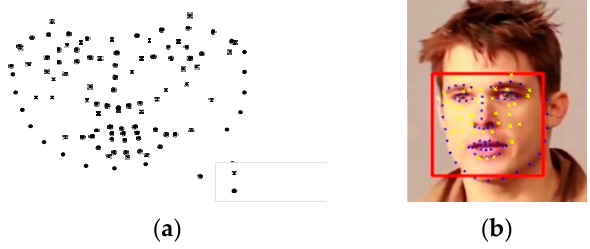
Figure 5. Acupoint visualization. ( a ) acupuncture model; ( b ) warped acupoints. Figure 5. Acupoint visualization. (a) acupuncture model; (b) warped acupoints. Figure 5. Acupoint visualization. (a) acupuncture model; (b) warped acupoints. Figure 5. Acupoint visualization. (a) acupuncture model; (b) warped acupoints.